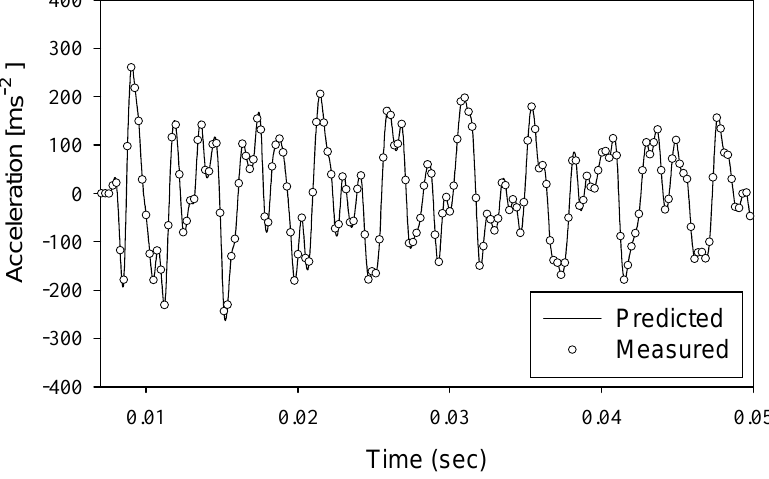
Fig. 12. Comparison of the measured and predicted accelerations at node 4 of the cantilevered beam with a bolt joint. dictions are in general very close to the experimentally measured